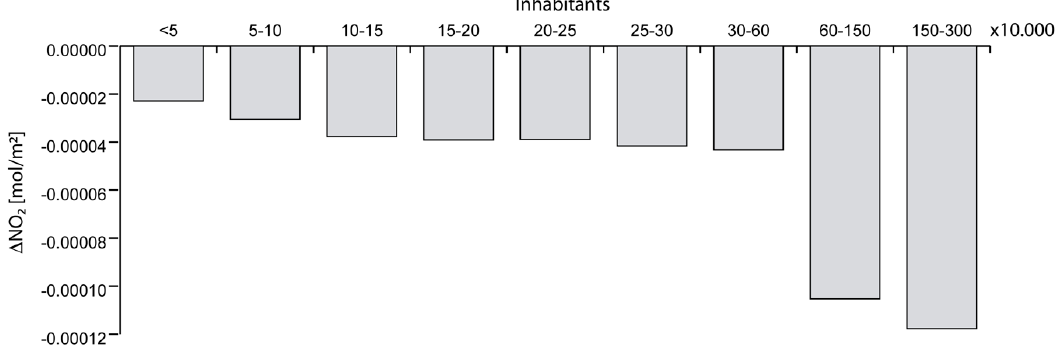
Figure 8. Number of inhabitants versus variation of tropospheric vertical column of NO 2 .